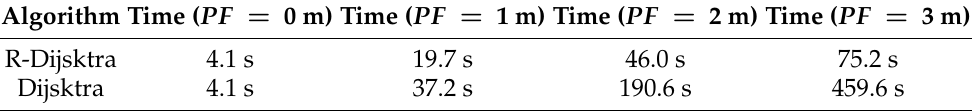
Table 2. Comparison between R-Dijsktra and Dijsktra.